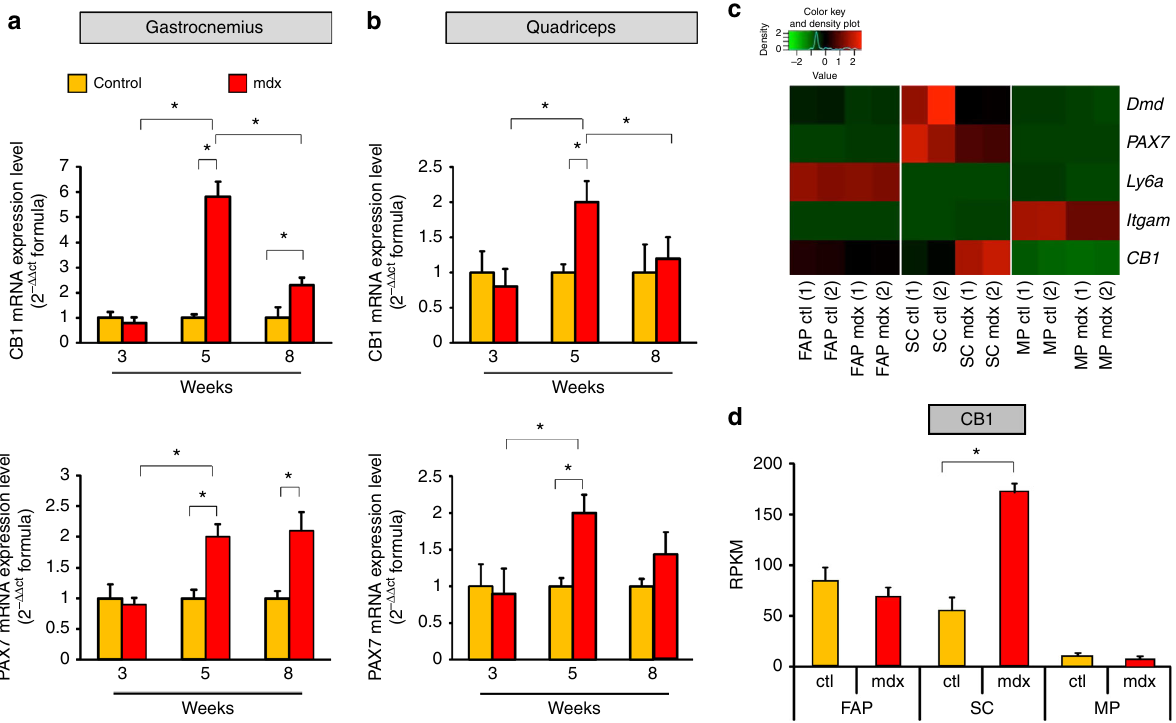
Fig. 1 CB1 and PAX7 gene expression in dystrophic skeletal muscles and cells. a, b Time course of CB1 and PAX7 mRNA expression levels in gastrocnemius ( a ) and quadriceps ( b ) muscle of control (dark yellow columns) and mdx (red columns) mice of 3 ( n = 8), 5 ( n = 8), and 8 ( n = 8) weeks of age. The quanti fi cation of transcripts for CB1 and PAX7 was performed by quantitative real-time PCR. c Heatmap representation of selected genes obtained from RNA-seq analysis in fi broadipogenic (FAP), satellite (SC), and macrophage (MP) cells isolated from 8-week-old control ( n = 4) and mdx ( n = 4) mice. Red, upregulated; green, downregulated. d Bar graph showing RPKM (Reads Per Kilobase of transcript per Million mapped reads) normalized values for the CB1 gene obtained from RNA-seq analysis in isolated FAP, SC, and MP cells. Each bar is the mean ± SEM of the independent determinations. * P ≤ 0.05 vs. control animals or cells, determined by Student ’ s t